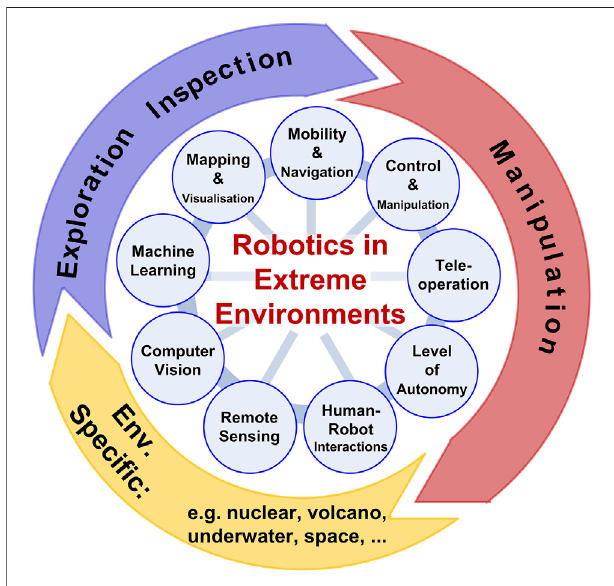
FIGURE 1 | Overview of research topics and challenges for Robotics in Extreme